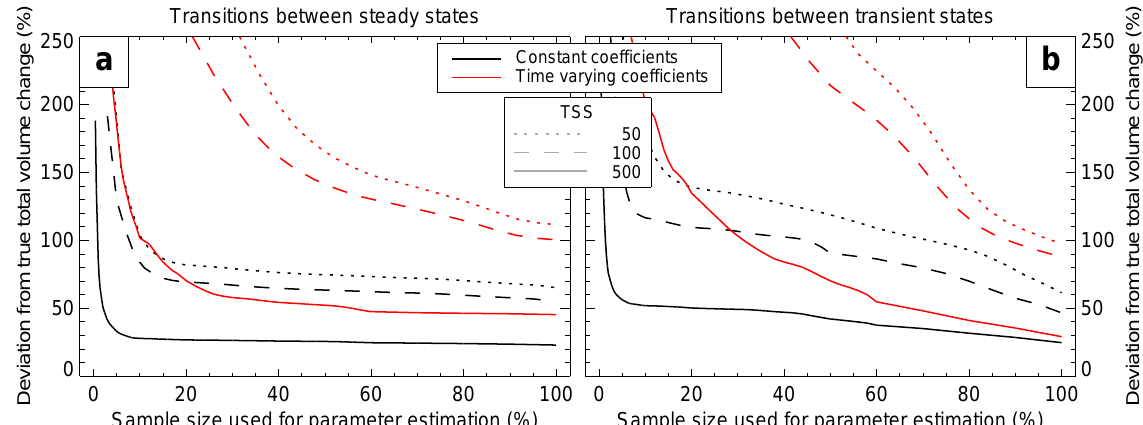
Fig. 3. Accuracy (95% of confidence) with which the true total volume change between two points in time t 1 and t 2 can be recovered by using volume–area scaling if the area of each individual glacier is known for both t 1 and t 2. In panel (a) both t 1 and t 2 refer to steady- state geometries, whilst in panel (b) the geometries are transient. Scaling parameters are assumed to be constant (black lines) or estimated separately for t 1 and t 2 (red lines). The different line styles depict different total sample sizes (TSS) for the glacier population.